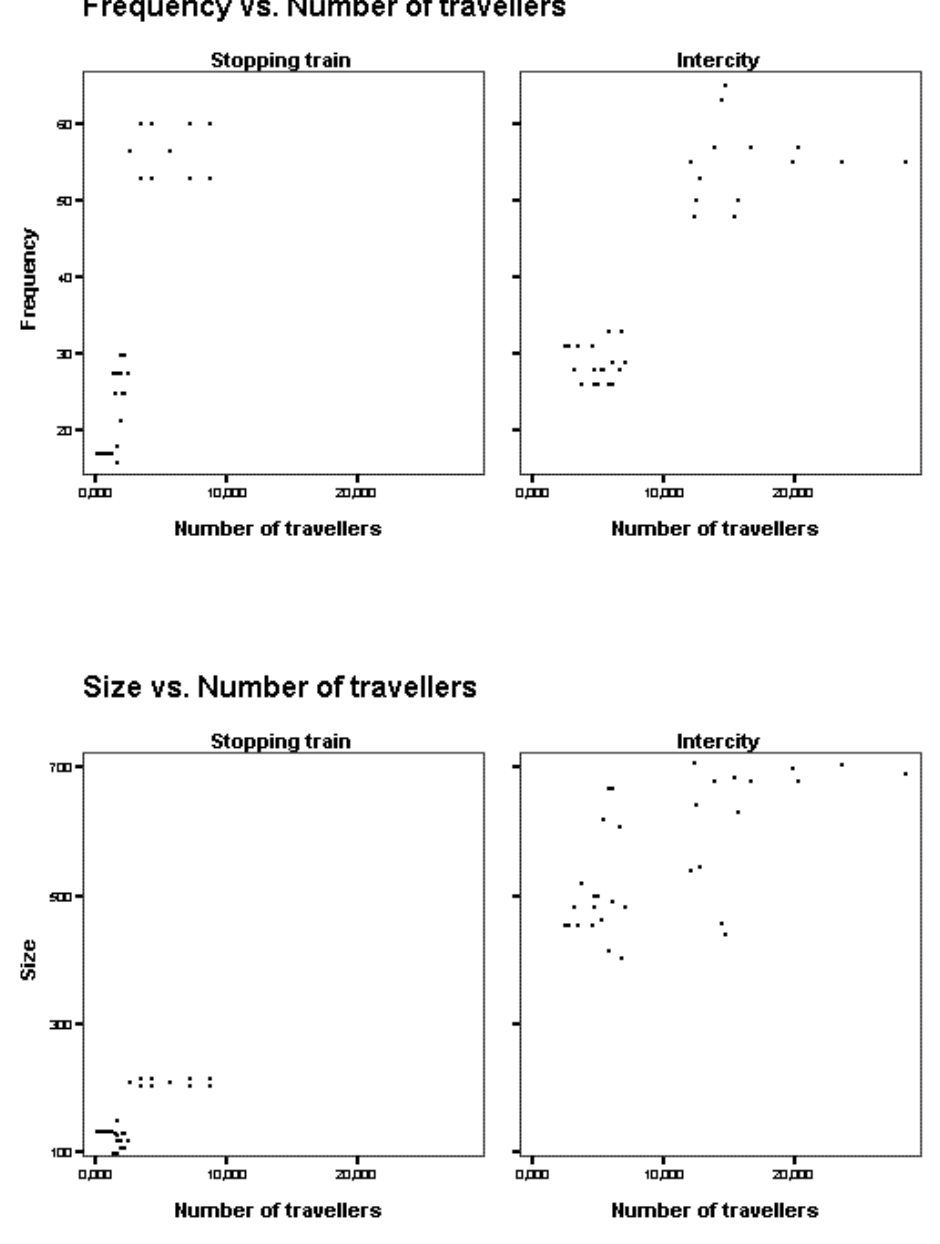
Figure 4. Service frequencies and number of seats per train for a sample of stopping trains and intercity trains in the Netherlands (off-peak,